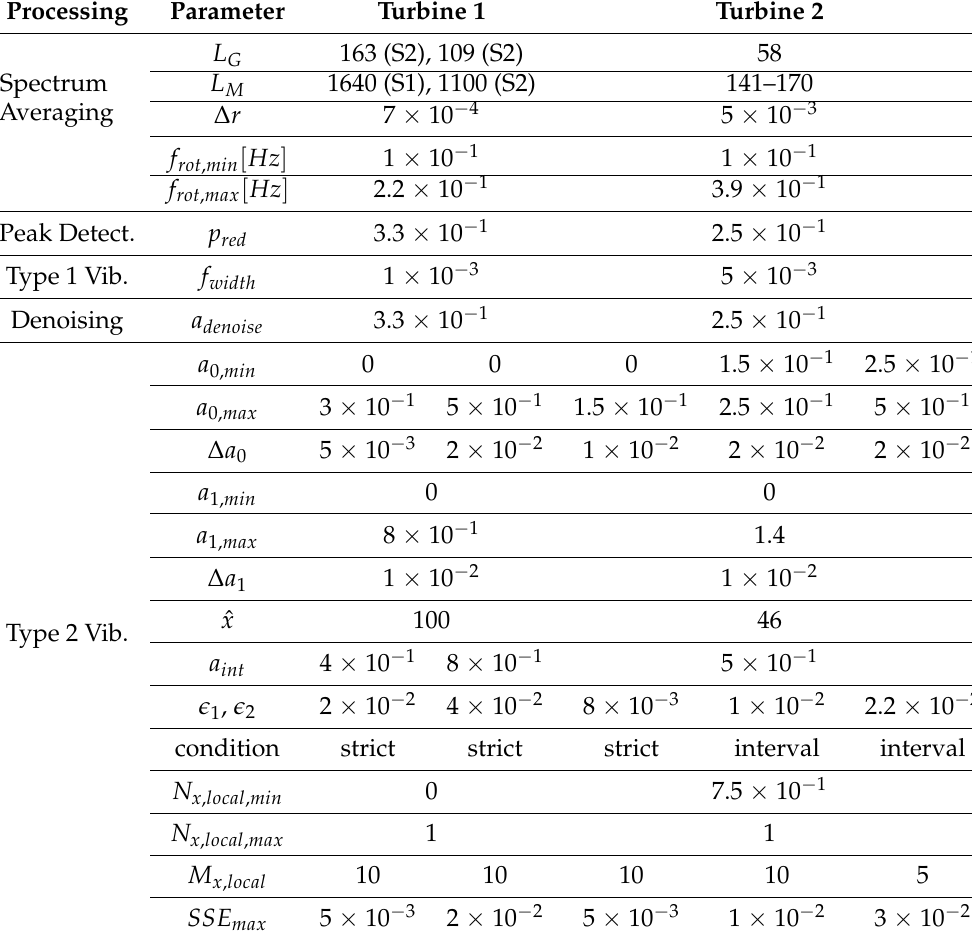
Table 1. Parameters of the fingerprint algorithm for sensors on Test Turbines 1 and